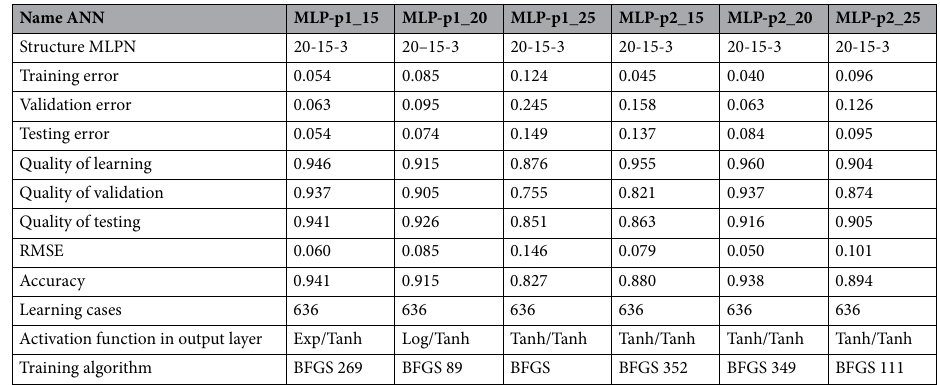
Table 2. Results of training process Artificial Neural